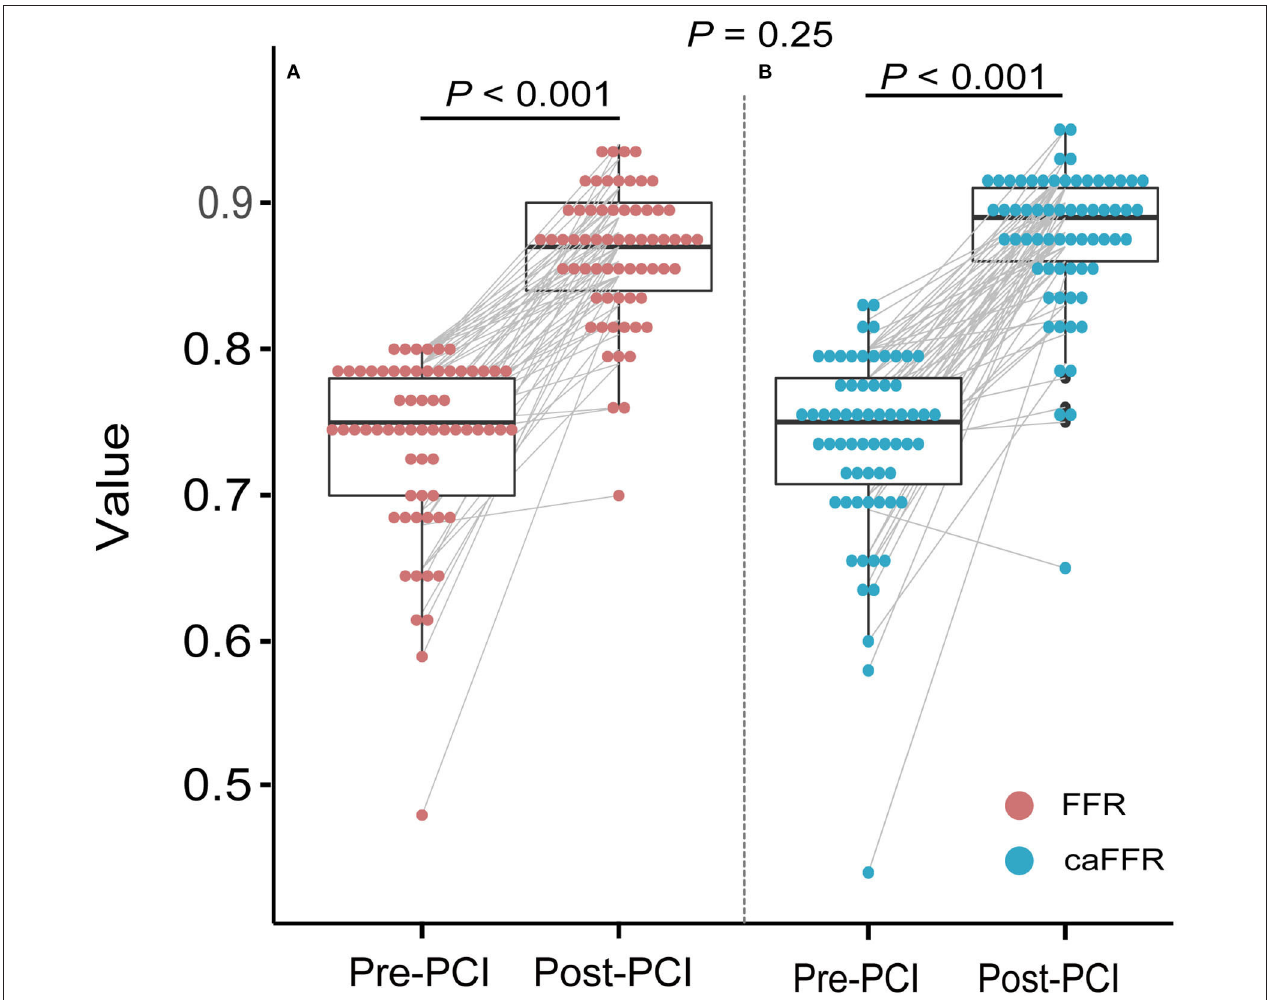
FIGURE 6 | Improvements in wire-based FFR and caFFR values after PCI ( n = 65). (A) The wire-based FFR values increased significantly after PCI (0.74 ± 0.07 vs. 0.86 ± 0.05, p < 0.001). (B) The caFFR values increased significantly after PCI (0.74 ± 0.07 vs. 0.88 ± 0.05, p < 0.001). The increase in wire-based FFR values after PCI were similar to that of caFFR values (0.13 ± 0.07 vs. 0.14 ± 0.08; p = 0.25). LAD, left descending artery; FFR, fractional flow reserve; PCI, percutaneous coronary intervention; caFFR, coronary angiography-derived